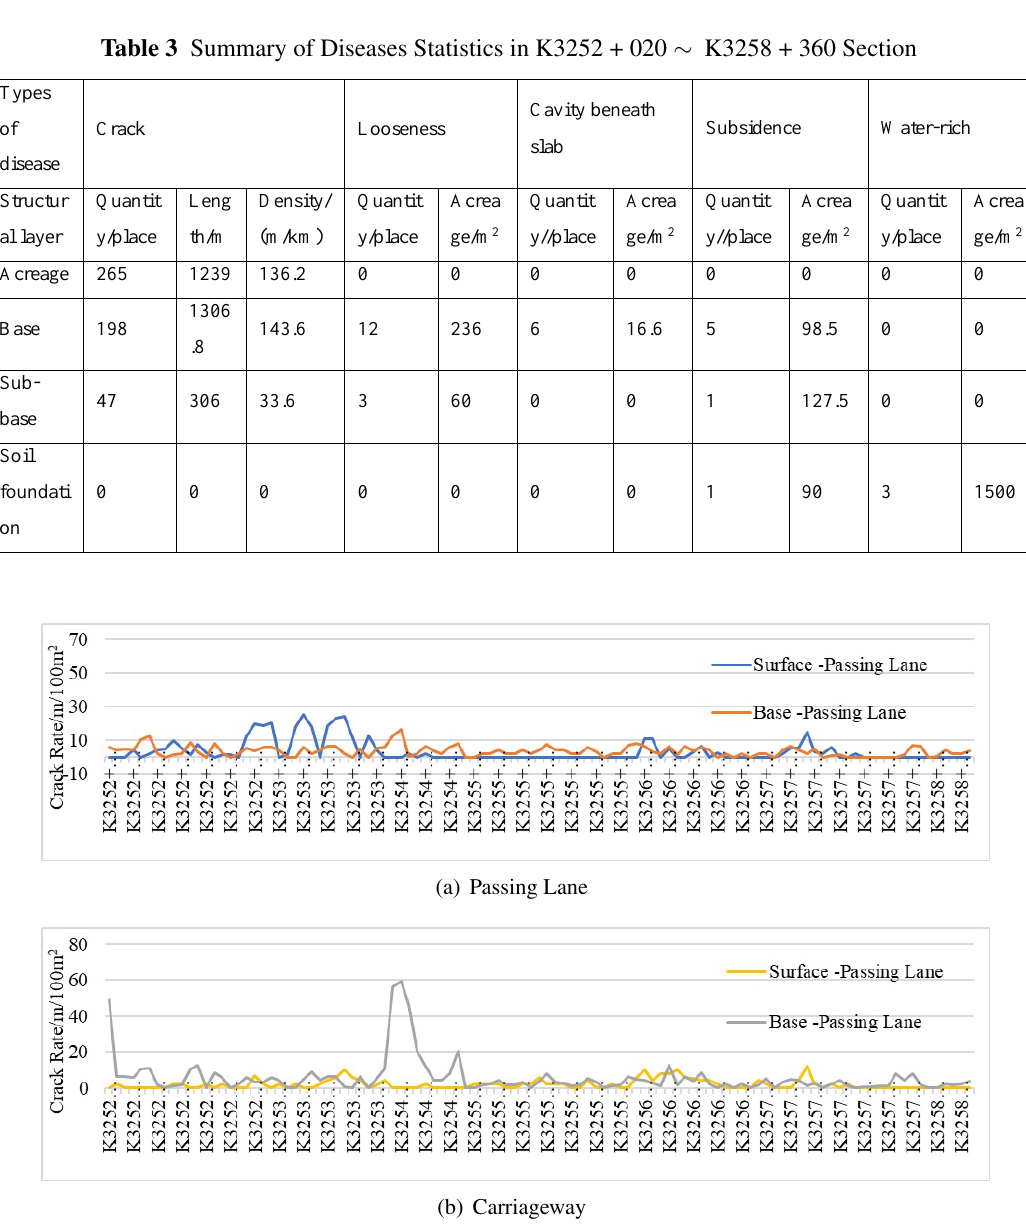
Fig. 3 Distribution of index of road surface damage condition in K3252 + 020 ∼ K3258 + 360